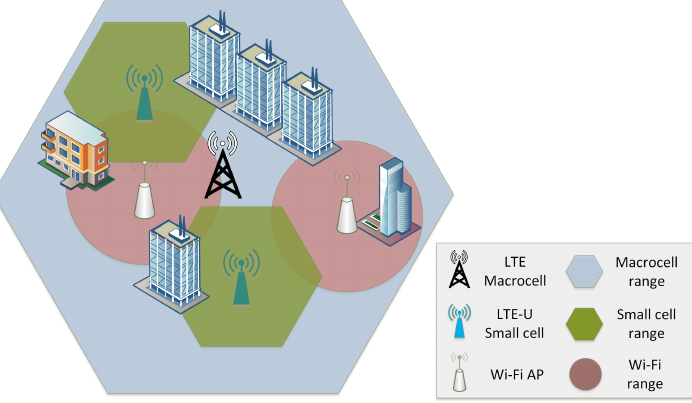
Figure 1. Deployment of LTE in the unlicensed spectrum next to the current